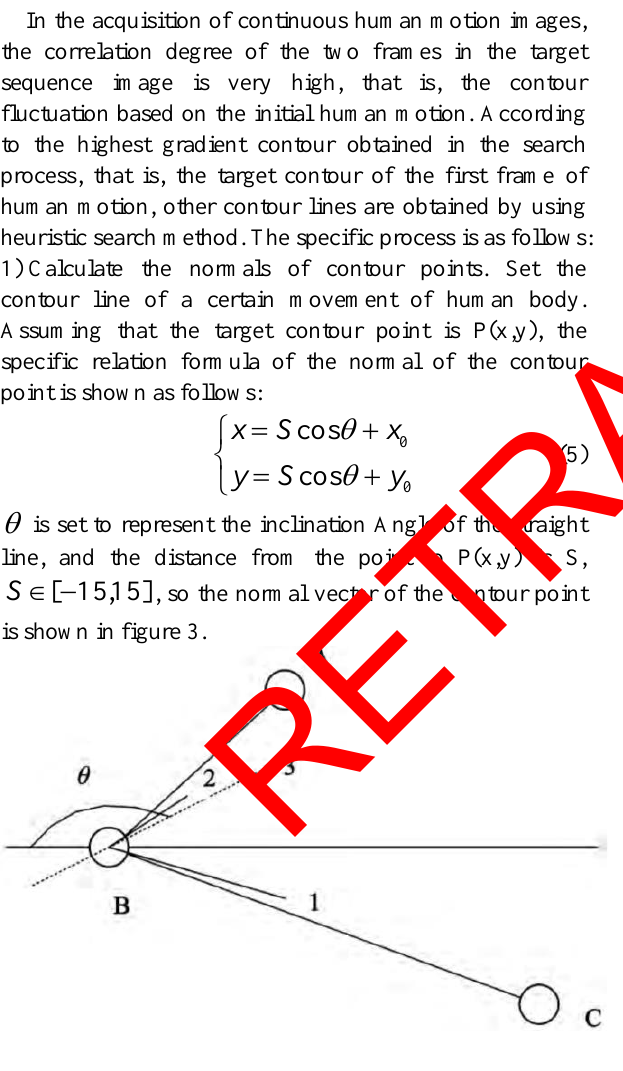
It can be seen from figure 3 that the normal vector 1 of line AB and the normal vector 2 of line BC are firstly